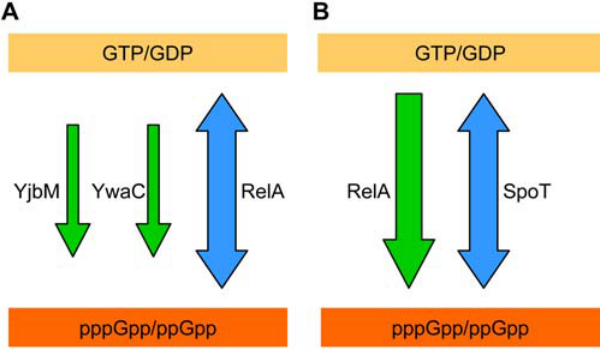
Figure 7. Metabolism of (p)ppGpp. A). Metabolism of (p)ppGpp in B. subtilis . (p)ppGpp is synthesized by the enzymes YjbM, YwaC and RelA, but degraded only by RelA. B). Metabolism of (p)ppGpp in E. coli . (p)ppGpp is synthesized by the enzymes RelA and SpoT, but degraded only by SpoT.